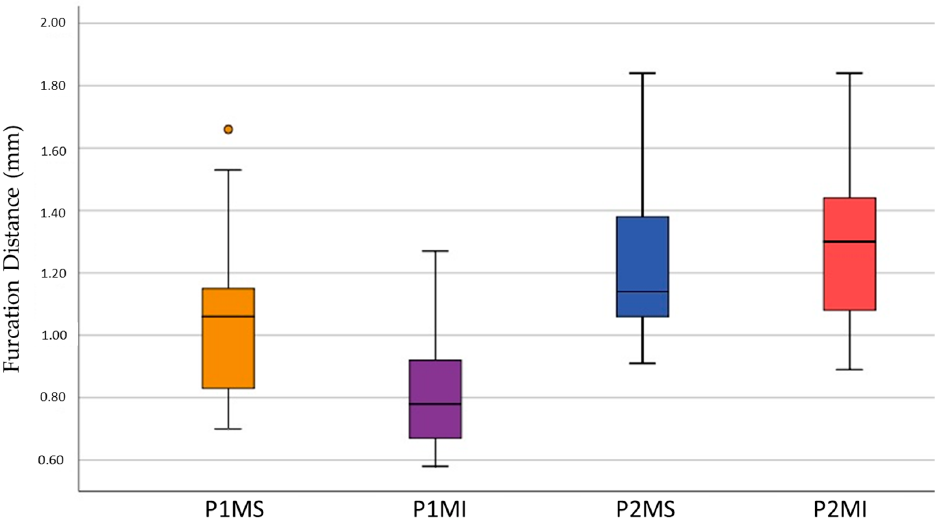
Figure 8 . Box plot of distance between pulp chamber floor and furcation (FD). Outlier data in the